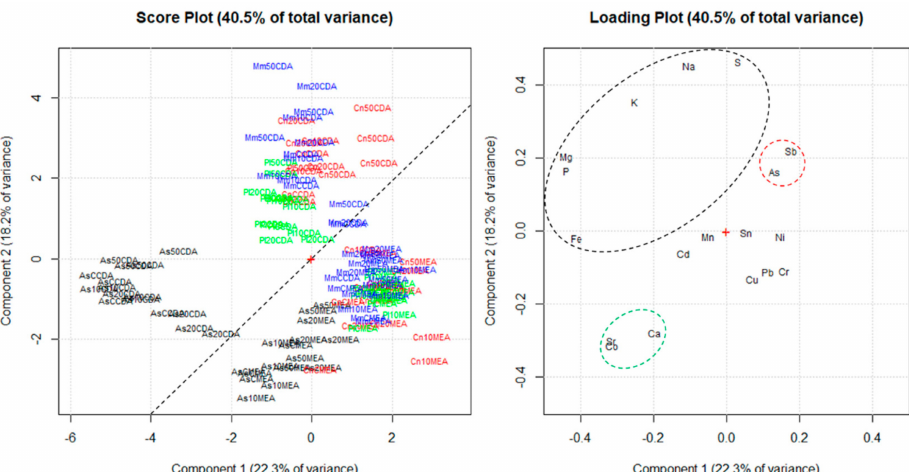
Figure 1. Score plot and loading plot of PC1 and PC2 obtained by the Principal Component Analysis (PCA) performed on the element concentrations determined in the fungal biomass of the tested species A. spinosa (As), C. nanum (Cn), M. marquandii (Mm), and P. lilacinum (Pl) grown on MEA and CDA media (C) and on MEA and CDA media added with 10 mg / L, 20 mg / L and 50 mg / L of sodium arsenite, respectively. Sample labels: AsCMEA, As10MEA, As20MEA, As50MEA, AsCCDA, As10CDA, As20CDA, As50CDA (black color); MmCMEA, Mm10MEA, Mm20MEA, Mm50MEA, MmCCDA, Mm10CDA, Mm20CDA, Mm50CDA (blue color); PlCMEA, Pl10MEA, Pl20MEA, Pl50MEA, PlCCDA, Pl10CDA, Pl20CDA, Pl50CDA (green color); CnCMEA, Cn10MEA, Cn20MEA, Cn50MEA, CnCCDA, Cn10CDA, Cn20CDA, Cn50CDA (red